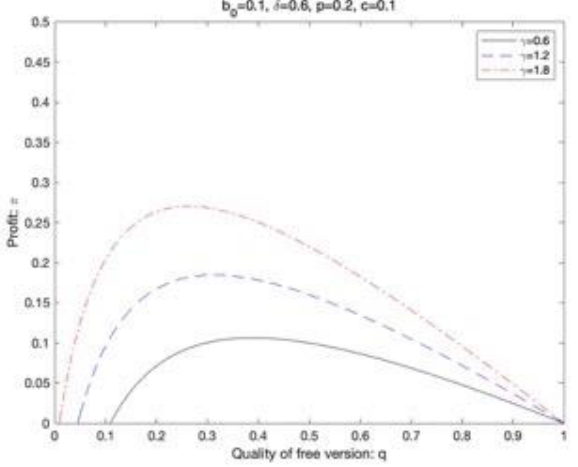
Figure 2. The impact of 𝑞 on 𝜋 for different network effect intensities.